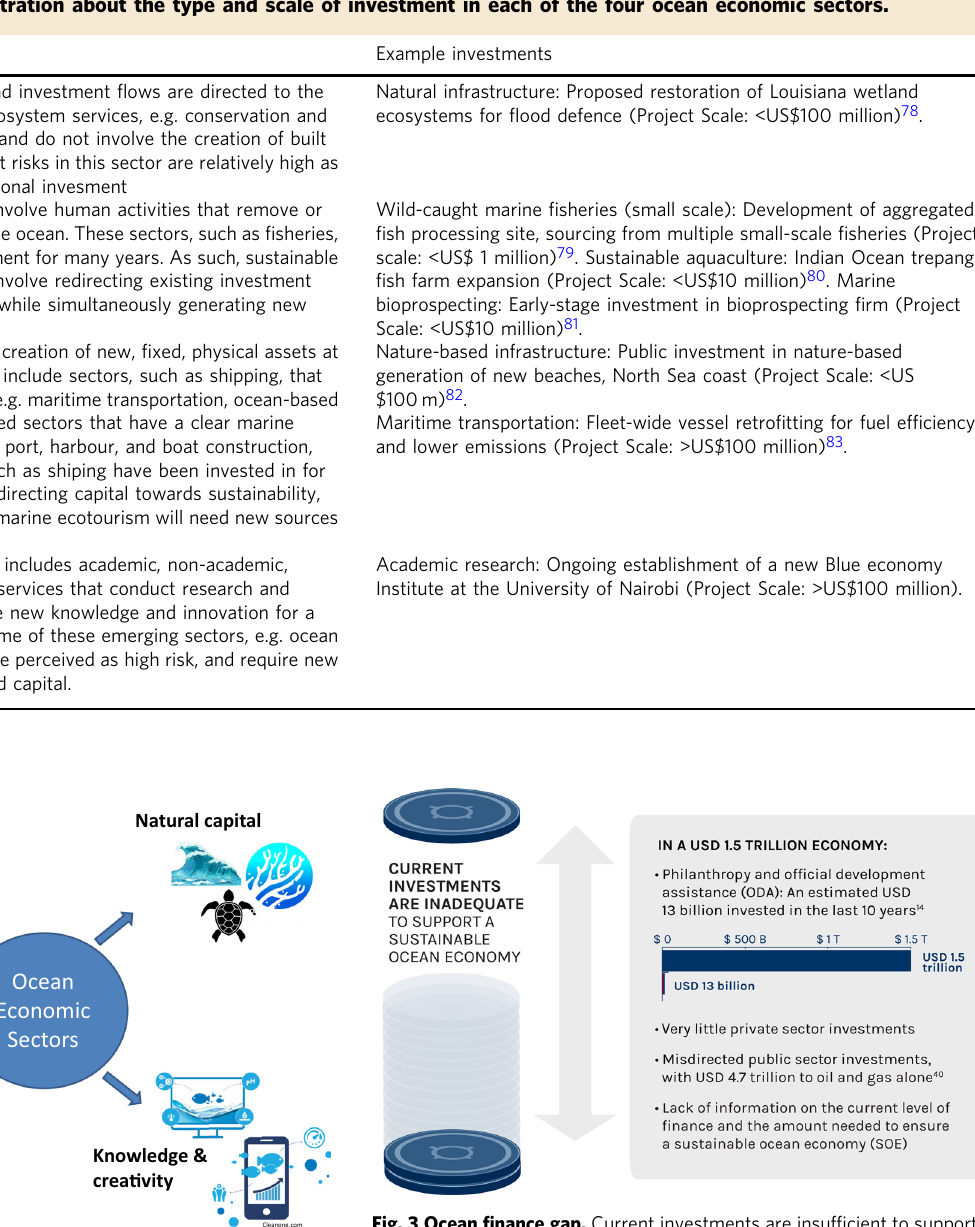
Fig. 3 Ocean fi nance gap. Current investments are insuf fi cient to support a sustainable ocean economy, resulting in a large ocean fi nance